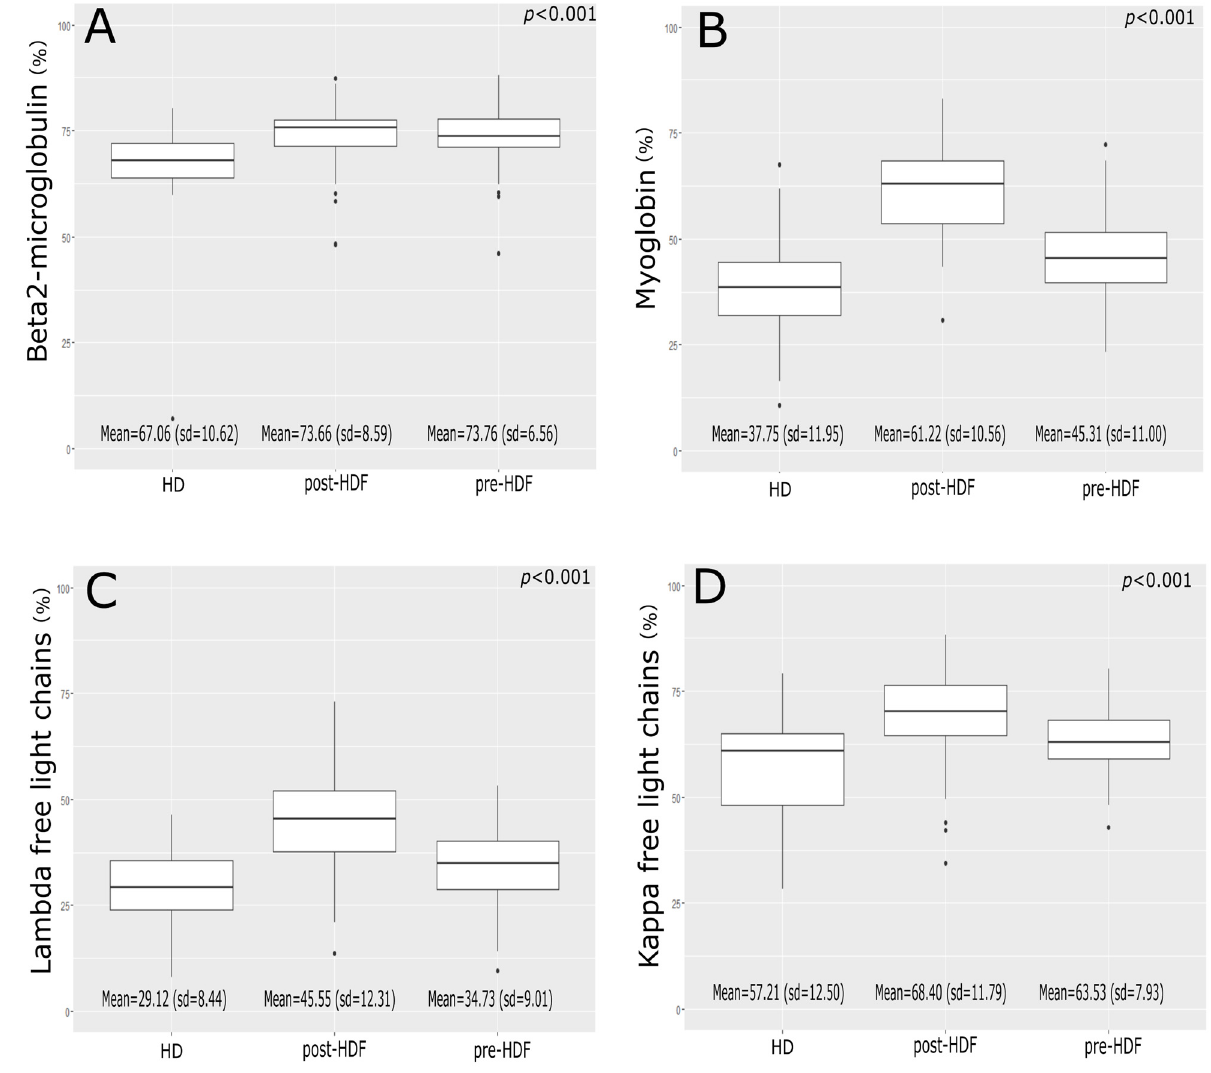
Figure 1. Middle molecules reduction ratio. ( A ) β 2µglobulin (beta2m), ( B ) Myoglobin, ( C ) Lambda free light chains, ( D ) Lambda free light chains. HD: Hemodialysis; HDF: Hemodiafiltration; sd: Standard deviation.